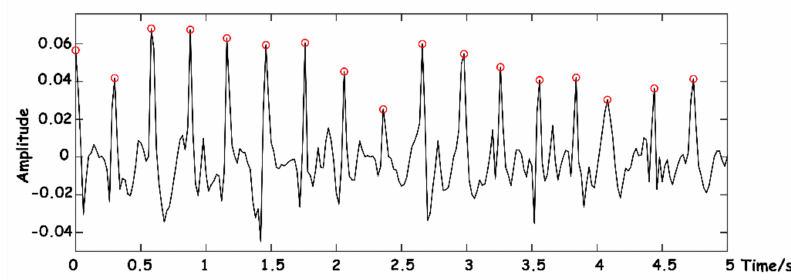
Figure 12. J-wave-peak extraction.